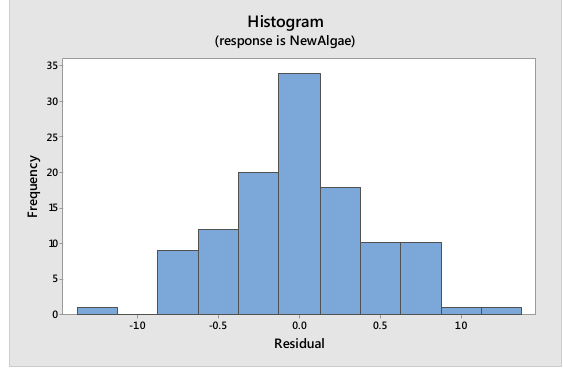
Figure 5. Residuals versus observation order.